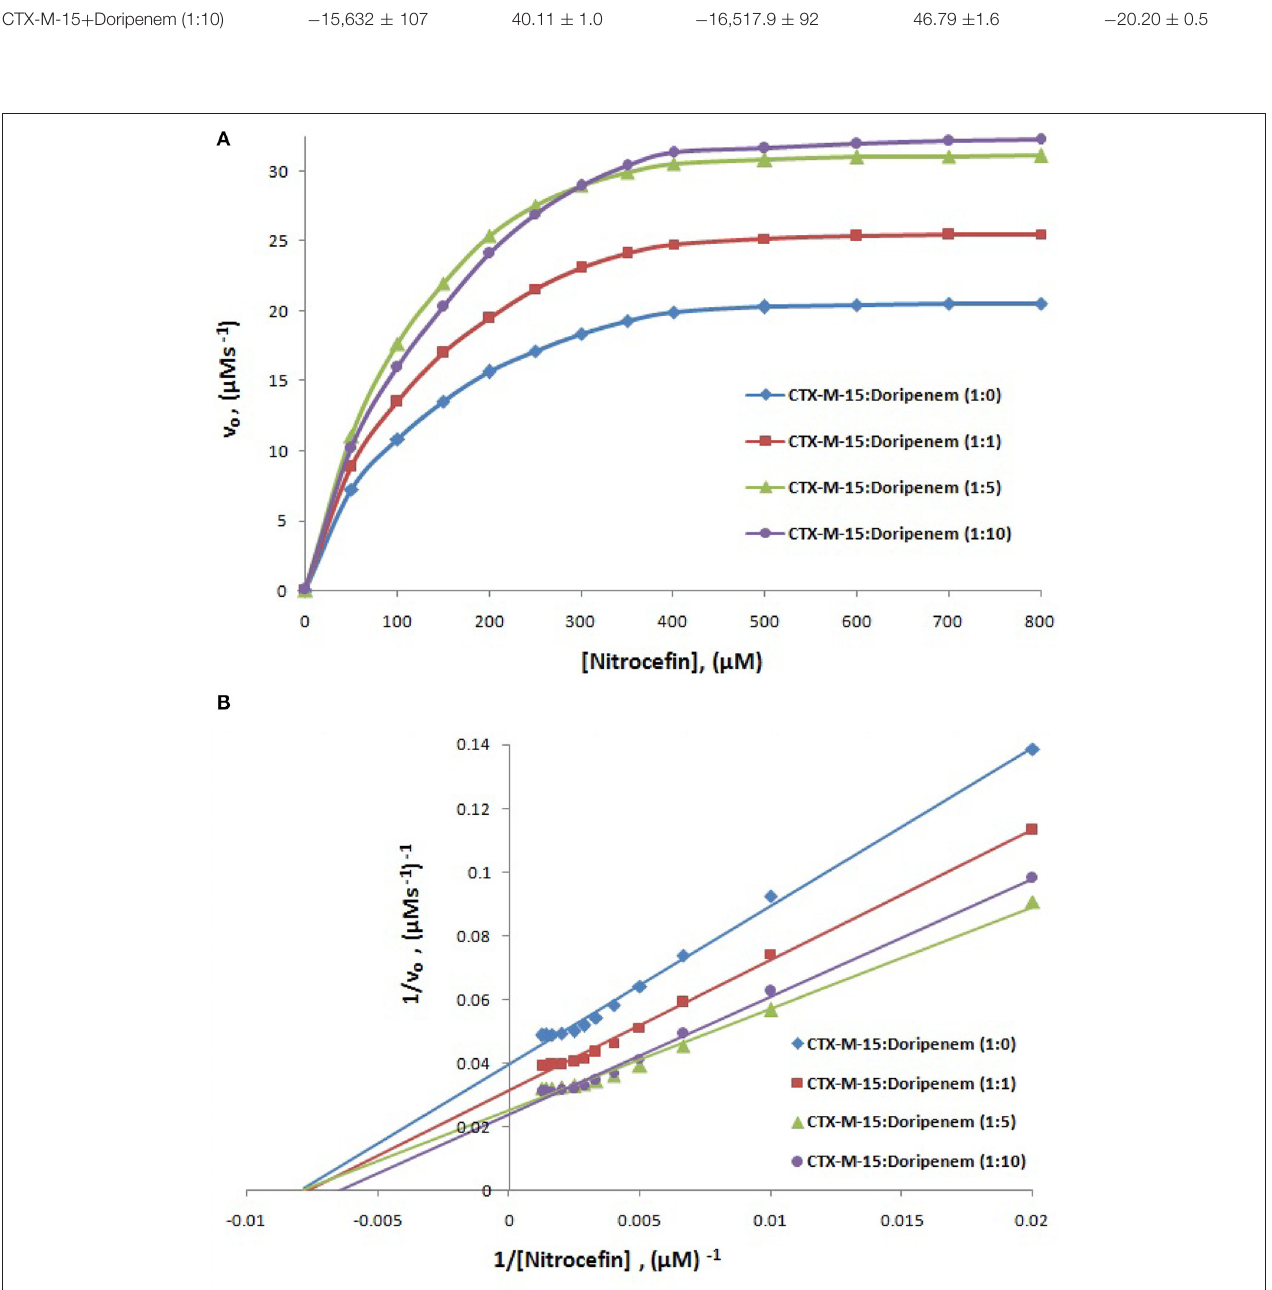
FIGURE 8 | Panel (A) shows Michaelis-Menten plot and panel (B) shows Lineweaver-Burk plot of Steady-state enzyme kinetics study of Nitrocefin hydrolysis by CTX-M-15 (5 nM) in the absence and presence of 5, 25, and 50 nM of doripenem at 298K in 50 mM sodium phosphate buffer, pH 7.4.